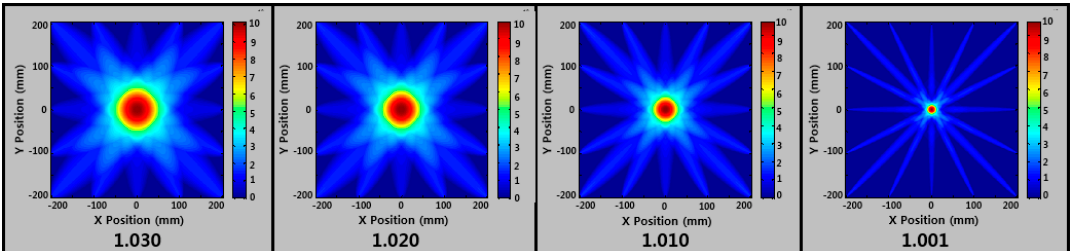
Figure 1. Image reconstruction results by using different values of parameter β .